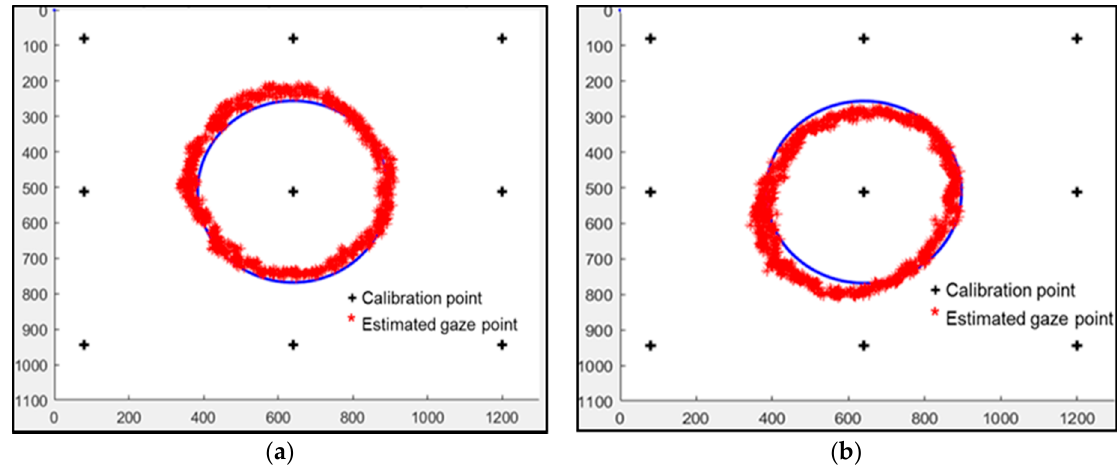
Figure 13. ( a ) Right eye estimated gaze points tracking the stimulus signal; ( b ) Left eye estimated gaze points tracking the stimulus signal. Note that blue circle represents cycle of the moving target.